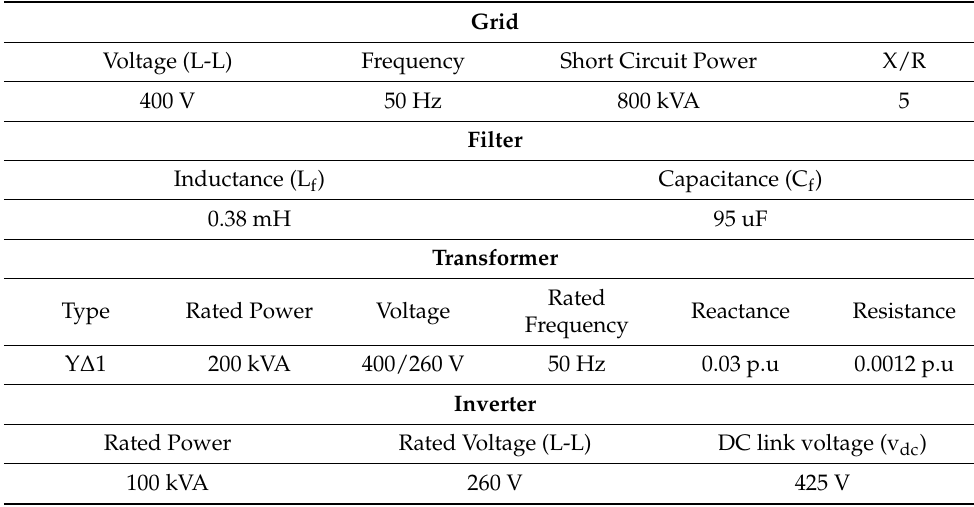
Table 1. Network Parameters.